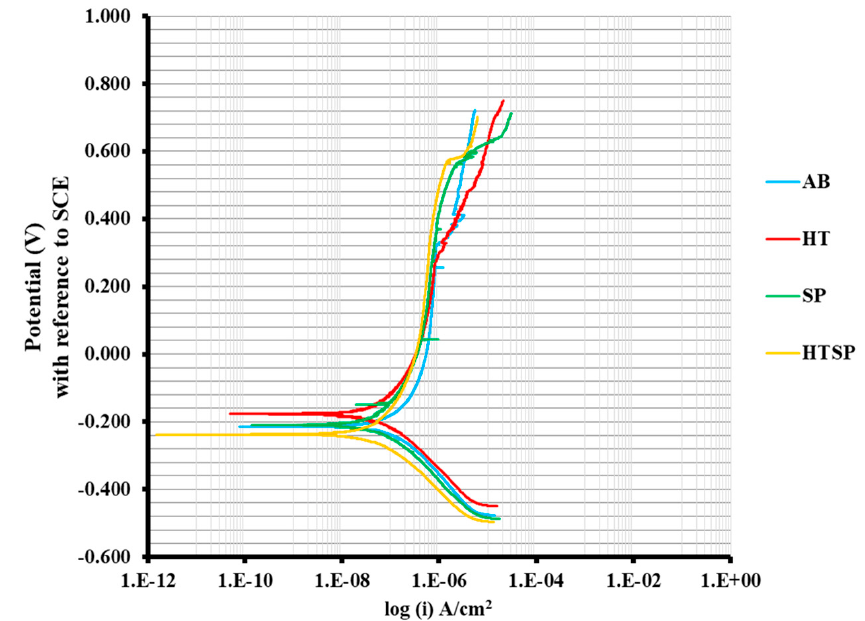
Figure 8. Tafel curve of SLM IN718 alloys.